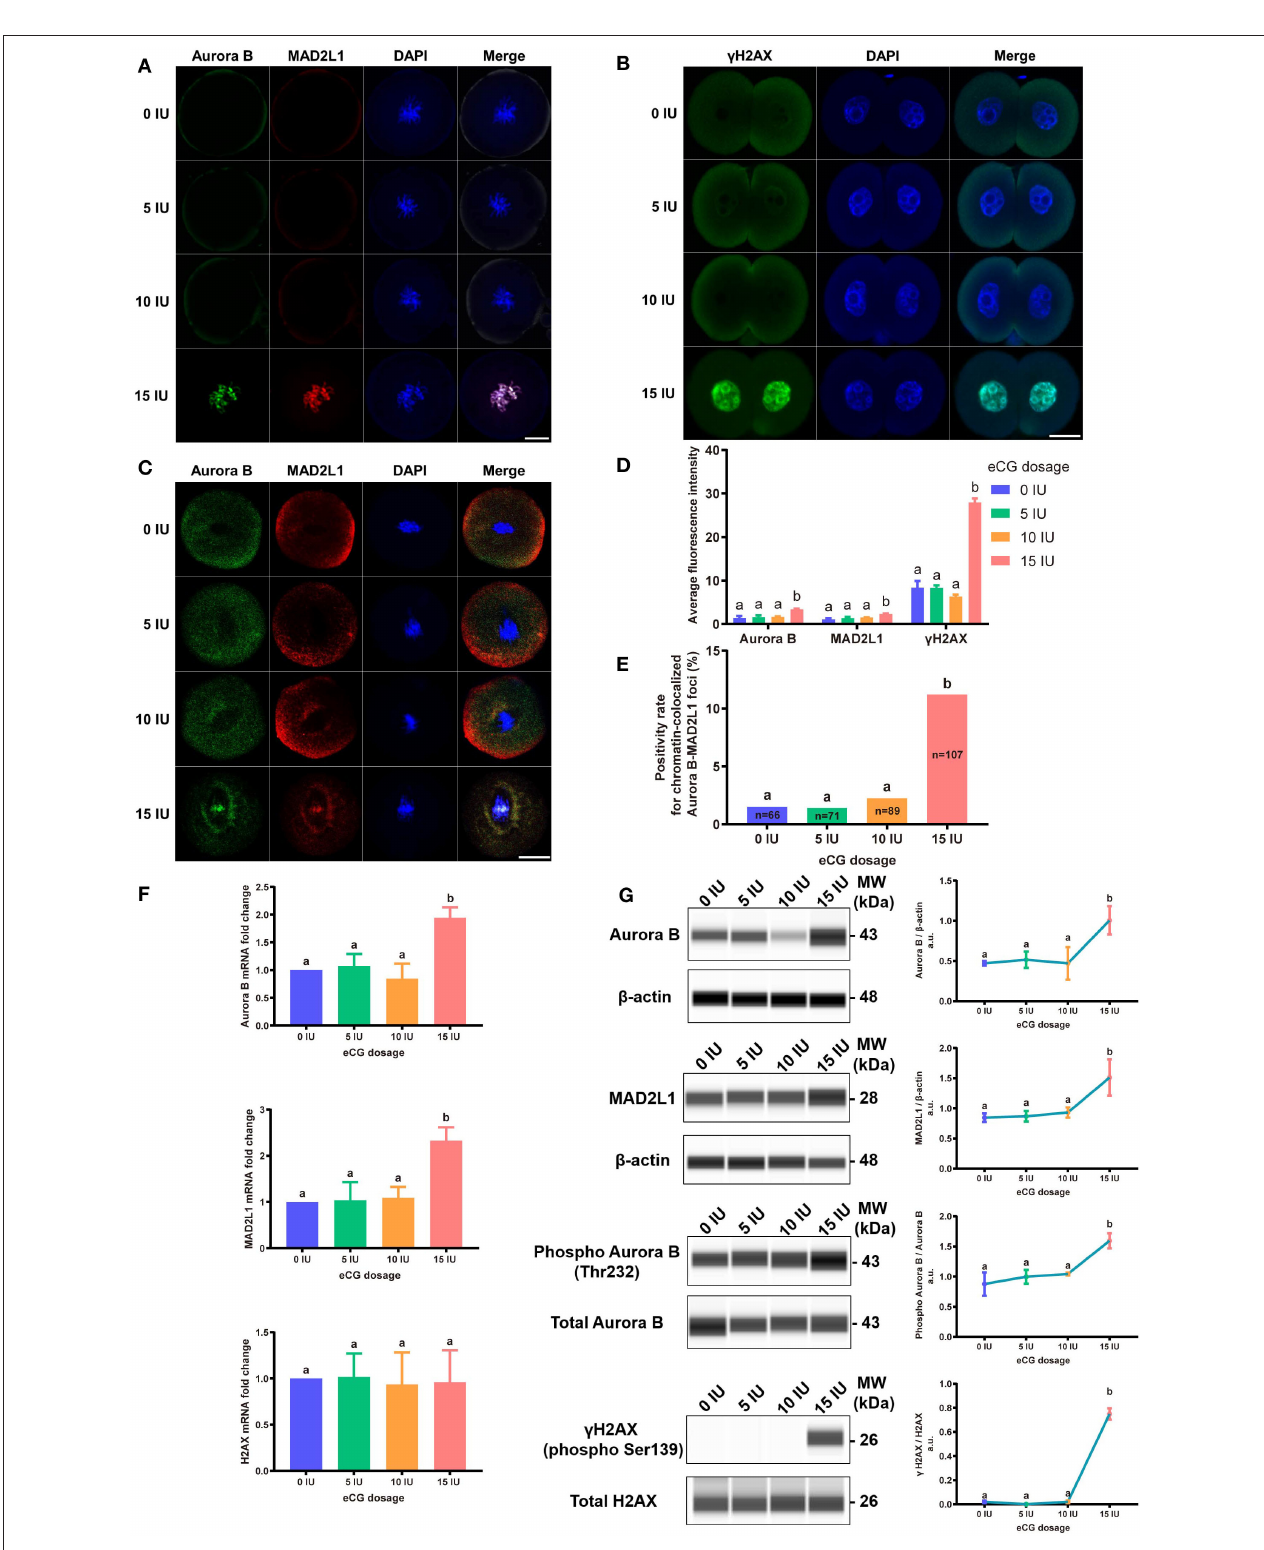
FIGURE 6 | Effects of different eCG doses on the expression profiles of γ H2AX, Aurora B, and MAD2L1 in IVF-derived mouse embryos. (A) The subcellular colocalization between Aurora B (green) and MAD2L1 (red) in IVF-derived mouse embryos from groups treated with different eCG doses was observed by immunofluorescence staining. The nuclei were stained with DAPI (blue). Scale bar = 20 µ m. (B) Representative photomicrographs of γ H2AX in each group. In the